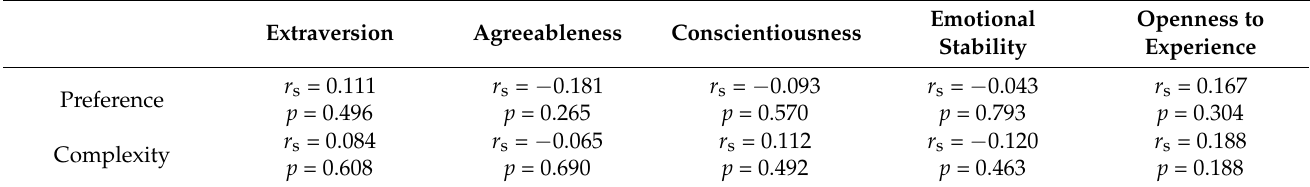
Table 6. Spearman’s correlation coefficient ( r s ) and p -values ( p ) between five personality and subjec- tive